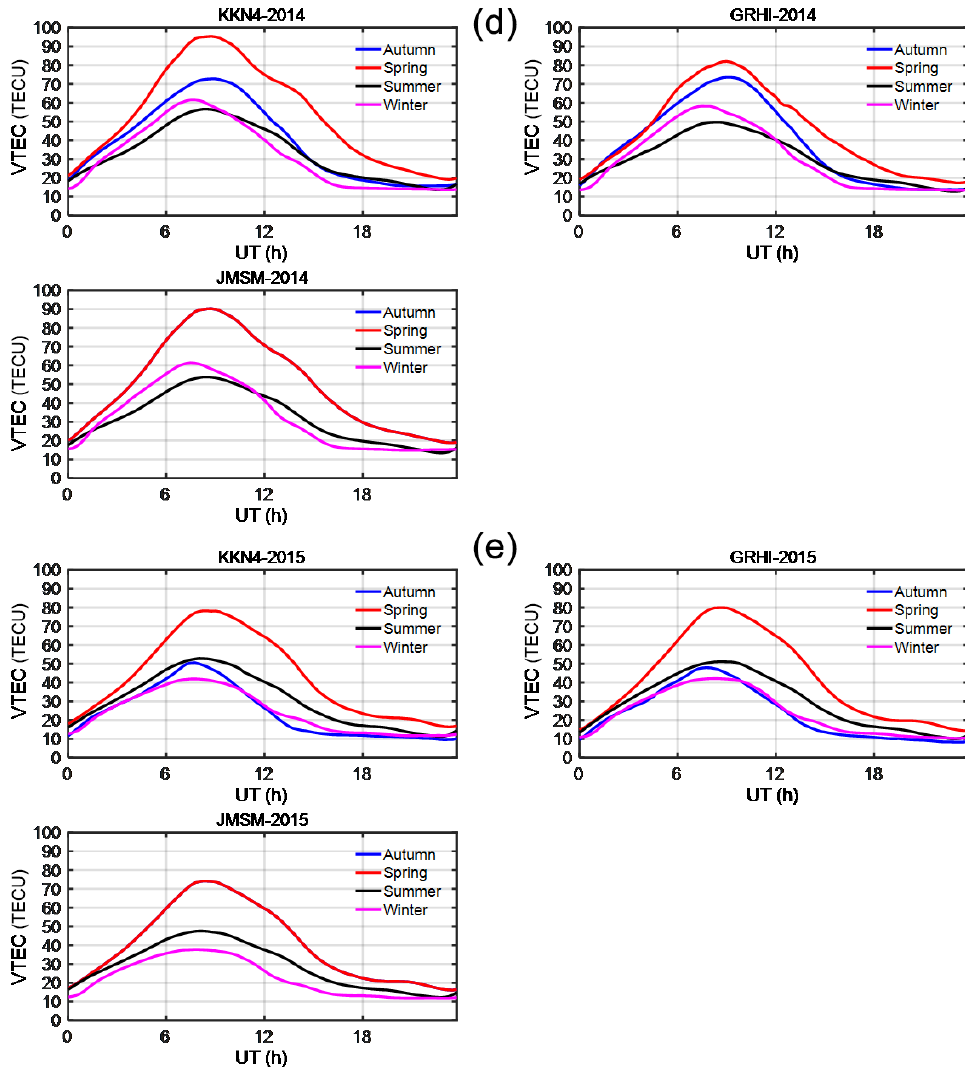
Figure 6. Seasonal variability in VTEC during years 2008 (a) , 2009 (b) , 2011 (c) , 2014 (d) and 2015 (e) for KKN4, GRHI, JMSM and DLPA